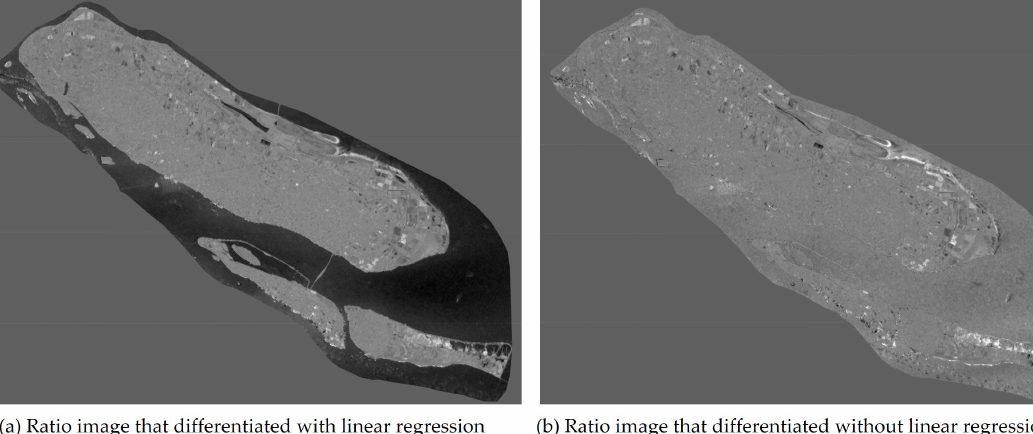
Figure 15. Comparisons of ratio